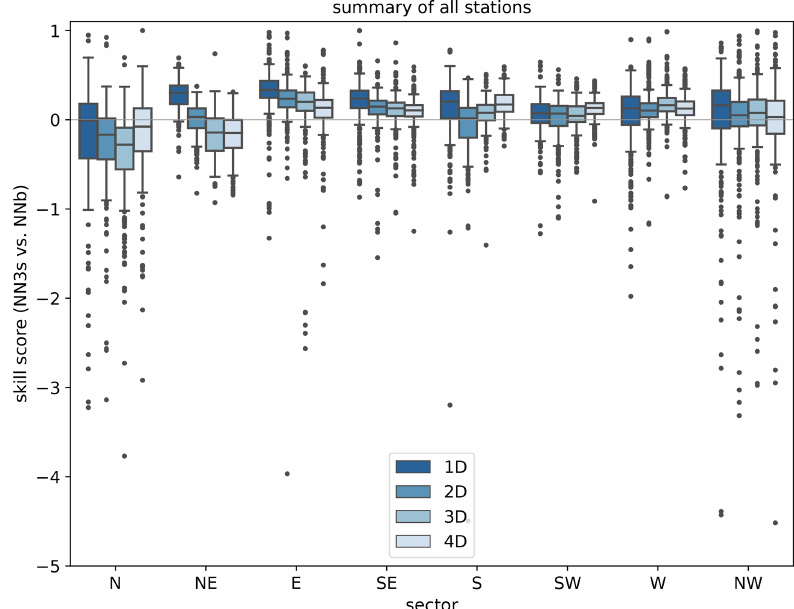
Figure 10. Skill scores (NN3s vs. NNb) based on the upstream wind direction at time step t 0 .